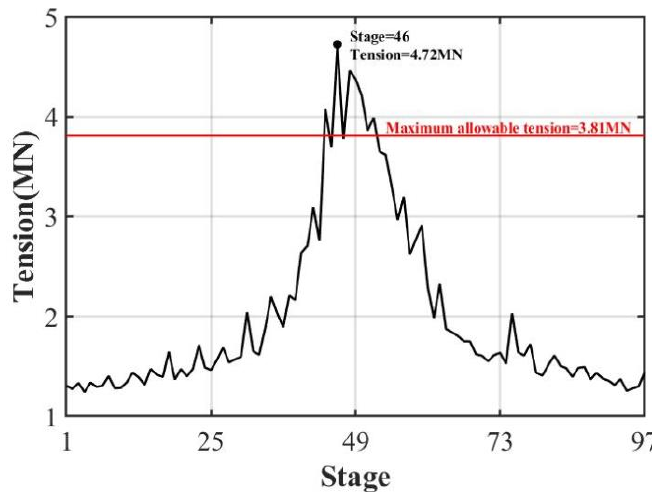
Figure 16. Maximum tension at different stages.